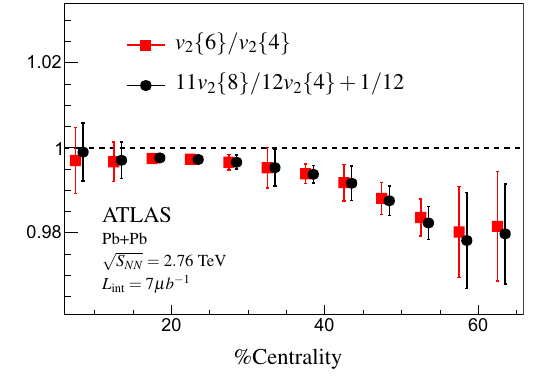
Fig. 9 Experimental values of ratios v 2 { 6 } /v 2 { 4 } and 11 v 2 { 6 } / 12 v 2 { 4 } + 1 / 12 with respect to the centrality class from the ATLAS data